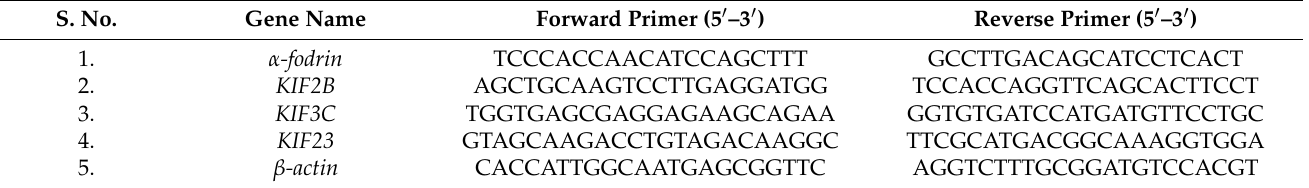
Table 1. List of the forward and reverse primers used for the real-time quantitative PCR of the mentioned genes. S.